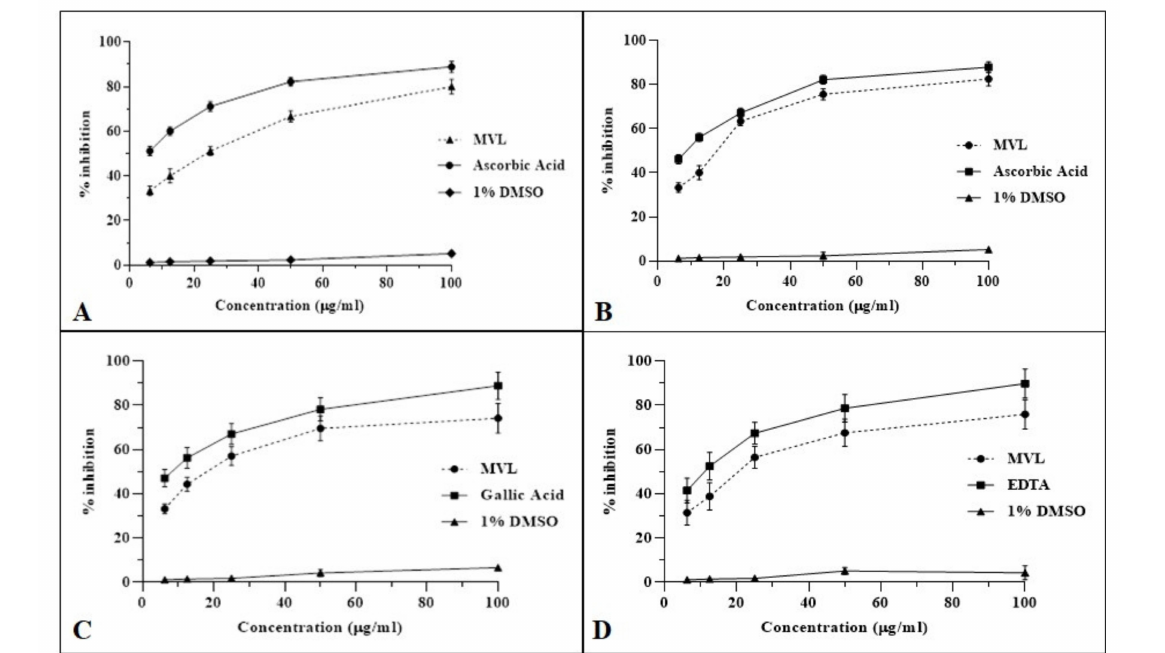
Figure 3. In vitro antioxidant activities of MVL. ( A ) DPPH radical scavenging activity, ( B ) NO scavenging activity, ( C ) OH • scavenging activity, and ( D ) iron-chelating % inhibition. Each value represents, Mean ± SD ( n =